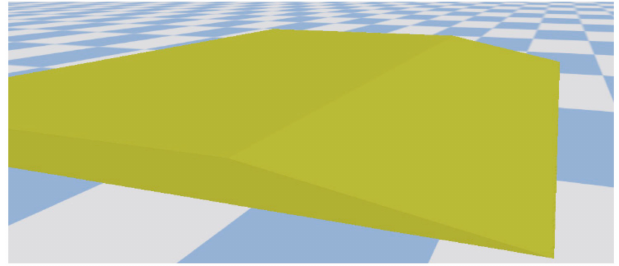
Figure 10. The simulation model of 5 ◦